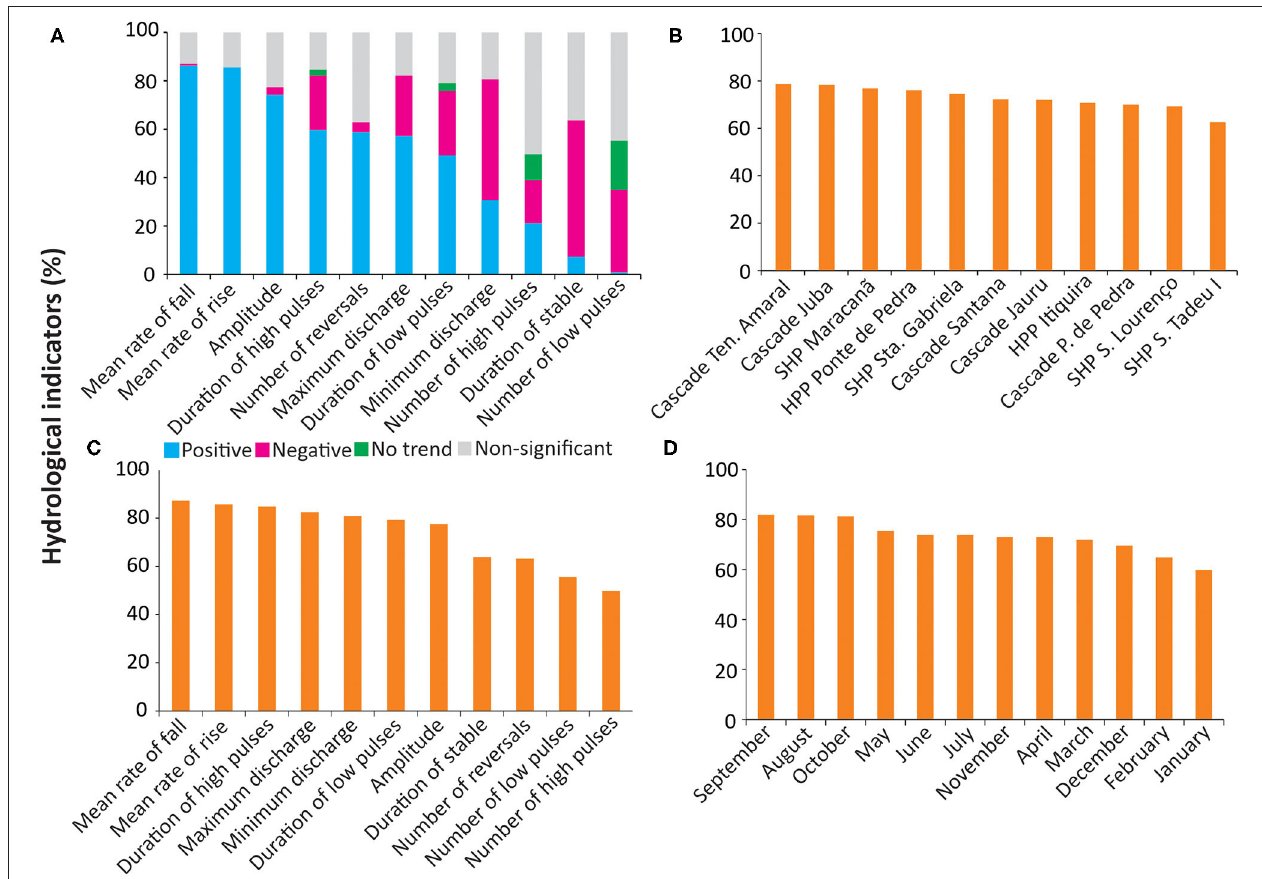
FIGURE 3 | Summary of the sub-daily indicators of hydrological alteration (HA): (A) Relative proportions of the monthly median values of HA showing significant positive values (increasing), negative (decreasing), no trend (indistinguishable medians) but with statistically significant differences in data distributions, and non-significant monthly medians; (B) Percentages of the hydrological indicators that showed statistically significant differences based on comparisons of daily values of each month, arranged by hydropower facility; (C) the same arranged by the indicators in Table 2 ; and (D) the same arranged by